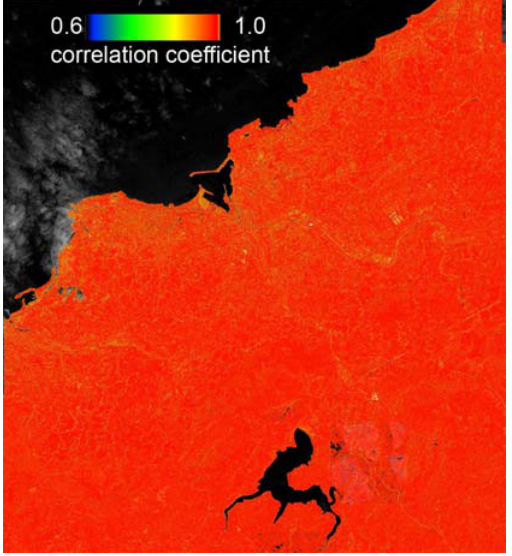
Figure 7. Distribution of correlation coefficients in scene combination centre and last image laid over Pleiades image Especially the combinations of the centre and first (CF) as well as centre and last (CF) image with convergence angles of 6.3° respectively 6.4° have very good frequency distribution of the correlation coefficients in the whole area. Their frequency distribution is nearly the same, so that the blue line for the image combination CF is hidden by the red line. For the convergence angle of 12.5° of the combination first to last image (FL) the correlation coefficient is not as good, nevertheless clearly better as for larger convergence angle (WV-2). With small convergence angle images are more similar to each other, even if the surface is not smooth. Figure 7 shows the very good correlation even in forest areas. Gaps of matching – with correlation coefficients below the chosen threshold of 0.6 – are only over water bodies, caused by clouds (centre left) and in extremely rough terrain or areas without texture (sports field).